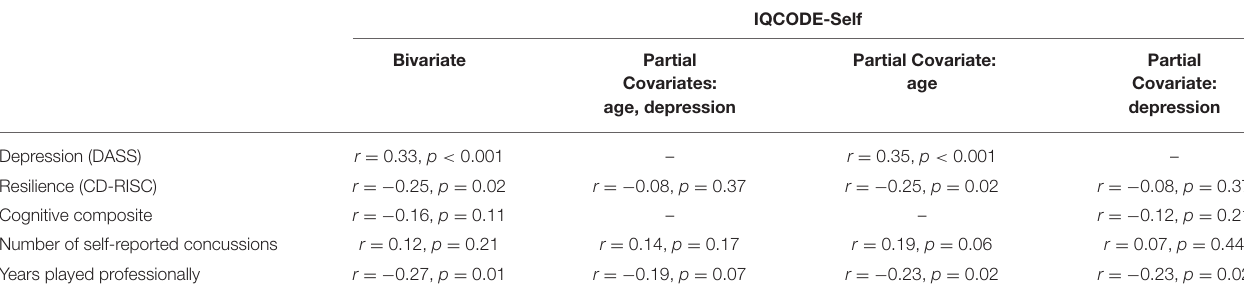
TABLE 5 | Spearman bivariate and partial correlations between IQCODE-self and variables of interest.